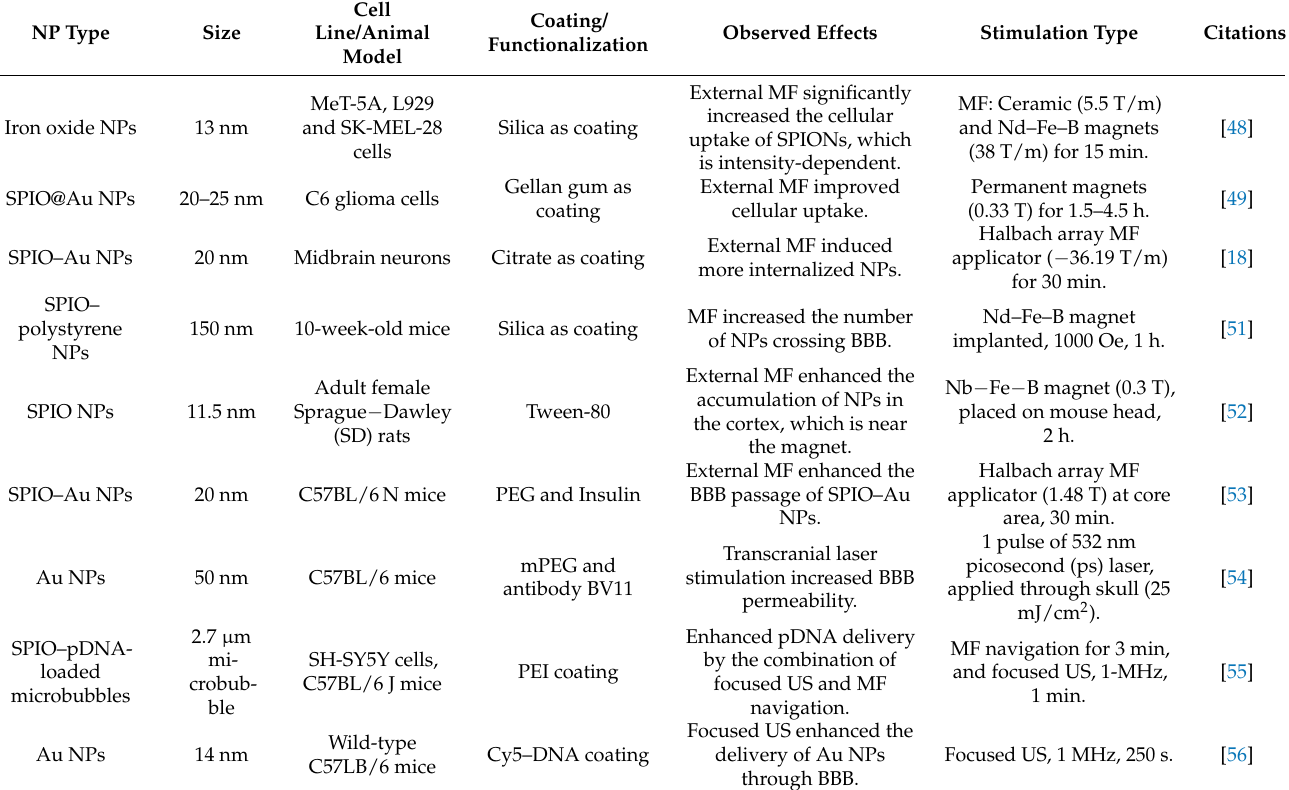
Table 1. Summary of the effects of external stimuli, including MF and focused US, on enhancing cellular uptake and BBB transfer of magneto-plasmonic